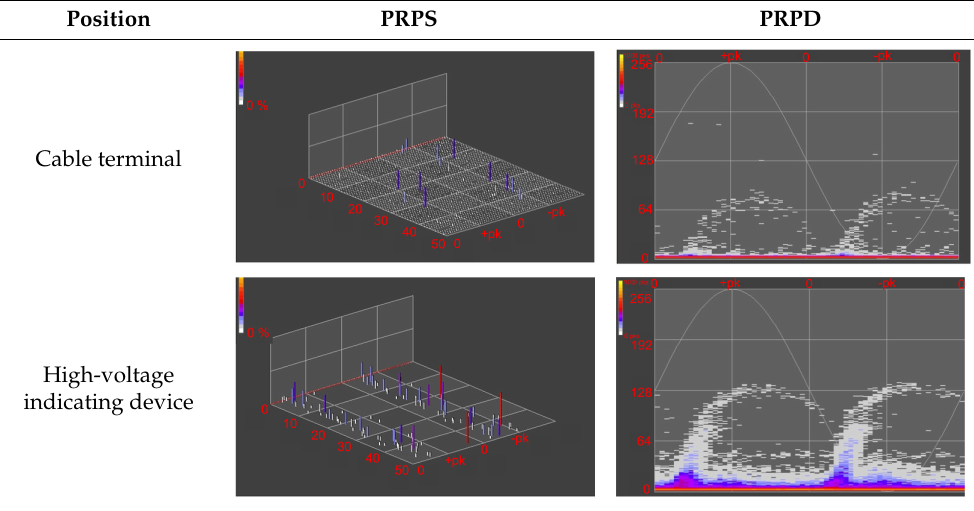
Table 4. Typical spectrum of UHF detection in A-phase cable